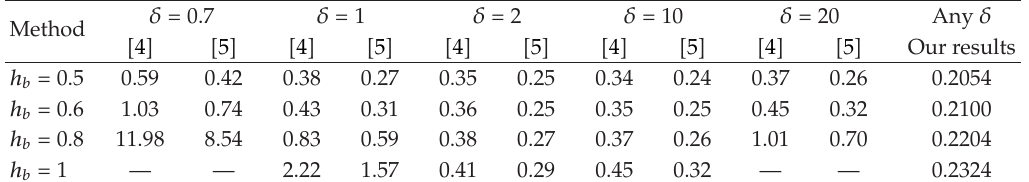
(cid:7) 0 . 2 (cid:3) d 2 1 unknown and